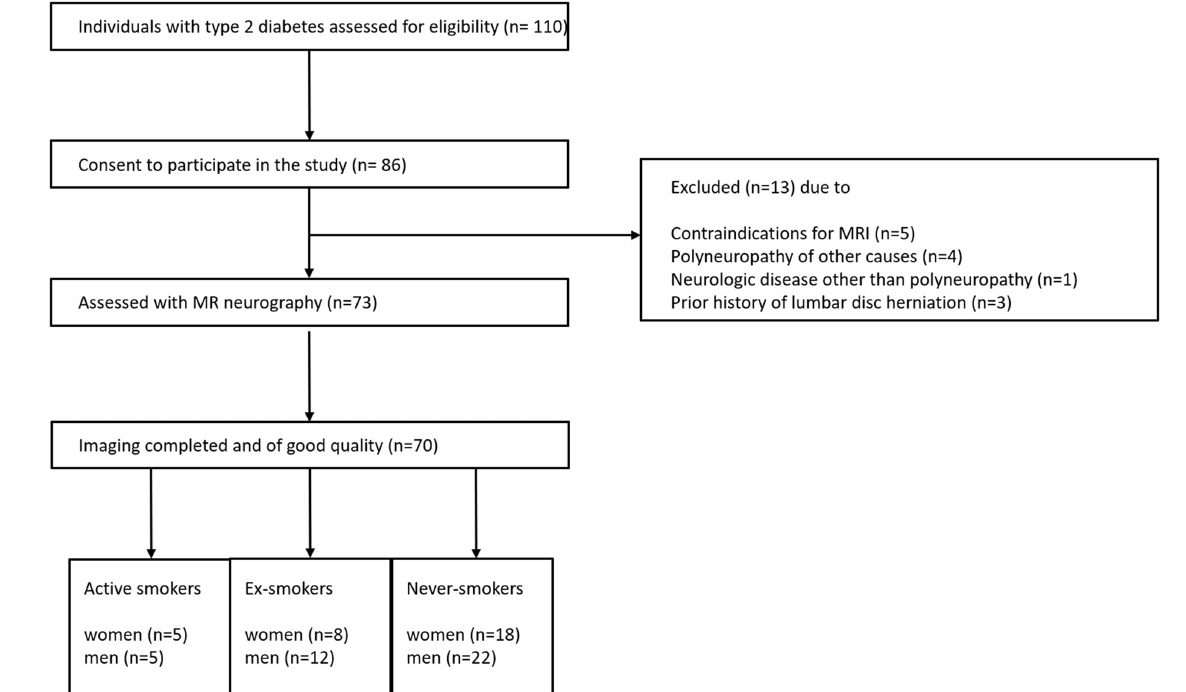
FIGURE 1 | Patient recruitment flowchart.